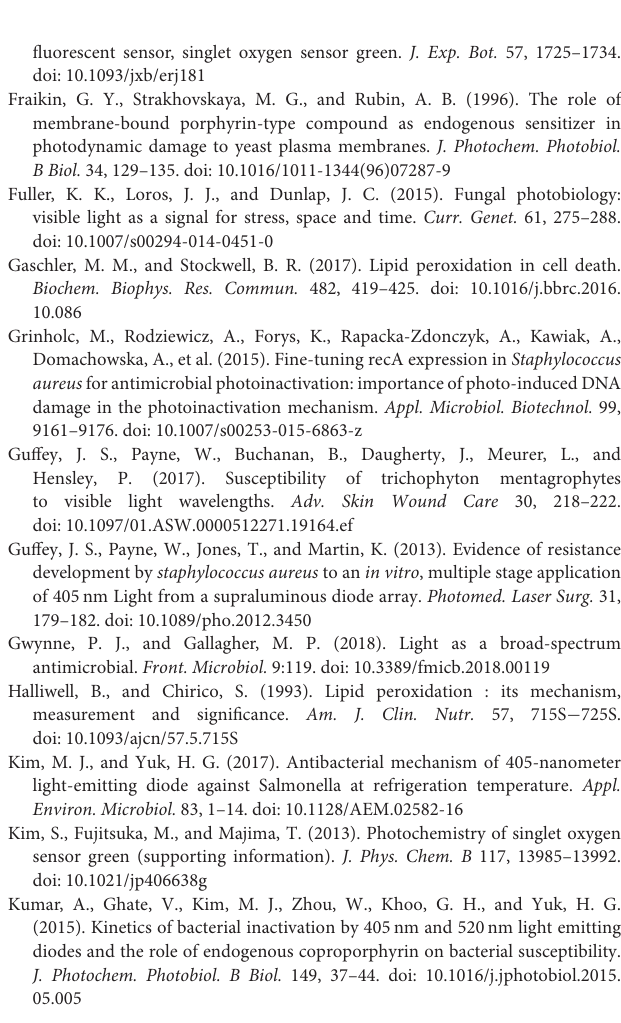
of 1.5.10 4 W/cm 2 at